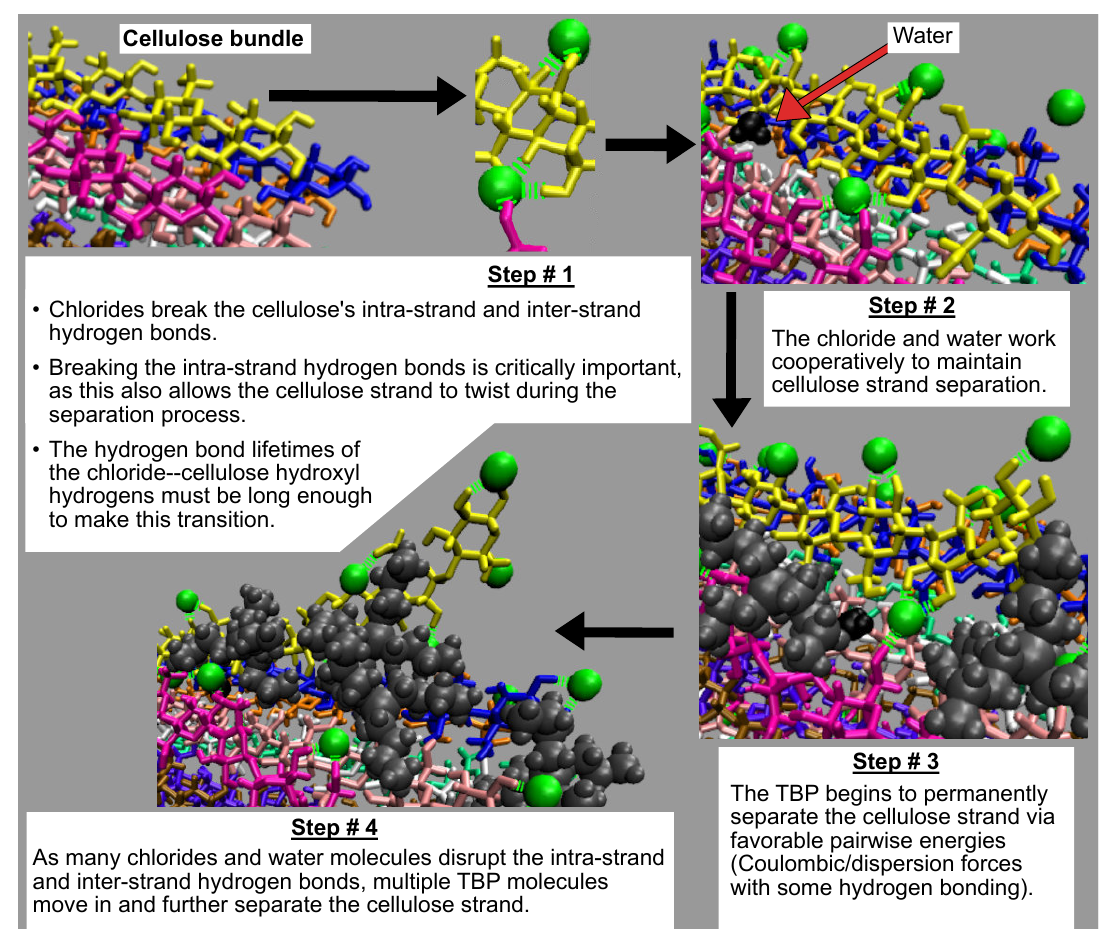
Figure 18. Summarized mechanism for cellulose dissolution in the TBPCl–water solution. These simulation snapshots are from the 63.1mol%water simulation. The green dashed lines indicate the chloride–cellulose hydrogen bonds. The water hydrogen bonds are not shown in this